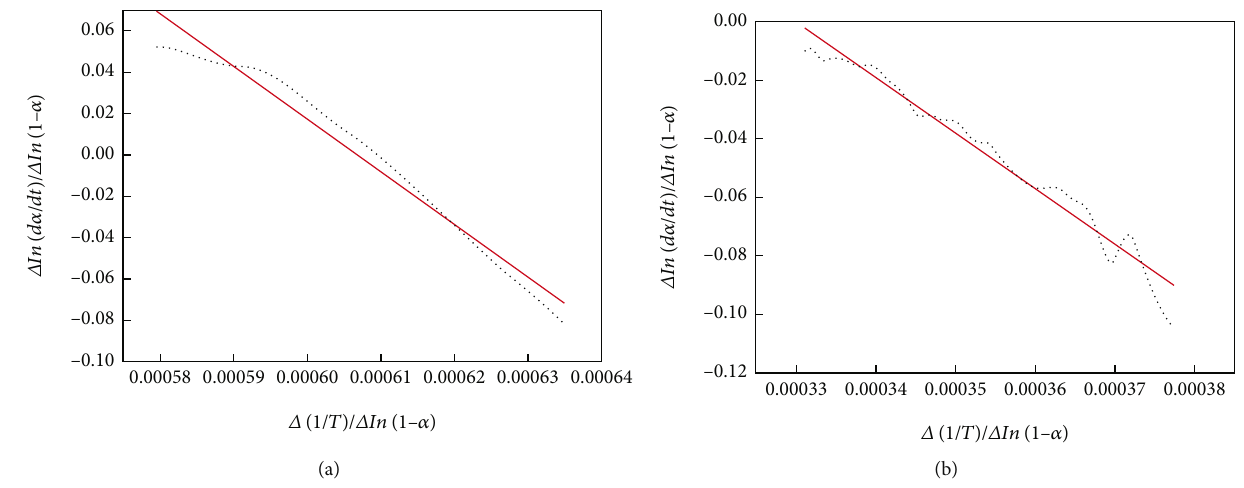
Figure 8: Thermal degradation kinetic curves of (a) SD +MA in 69.6 – 103.1 ° C and (b) SD +MA in 311.7 – 397.4 ° C.